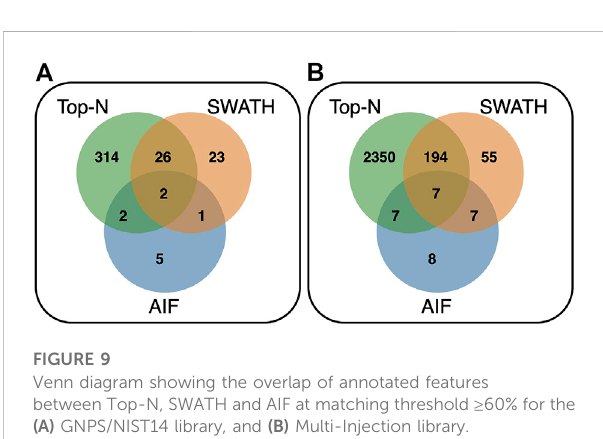
FIGURE 9 Venn diagram showing the overlap of annotated features between Top-N, SWATH and AIF at matching threshold ≥ 60% for the (A) GNPS/NIST14 library, and (B) Multi-Injection